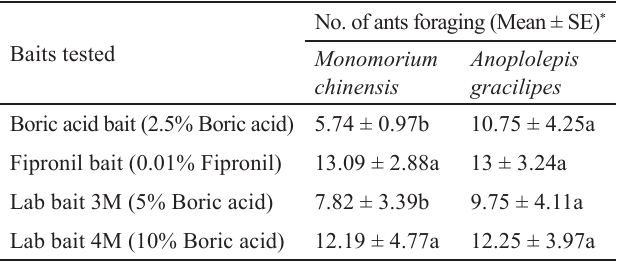
Table 3 . Preference of Monomorium chinensis and Anoplolepis gracili- pes on new molasses and commercial baits under laboratory